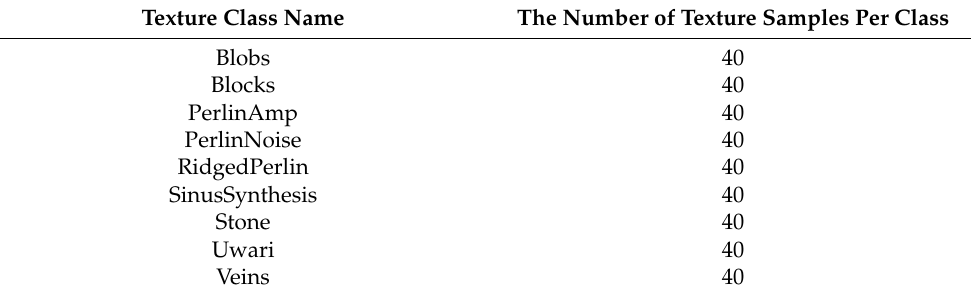
Table 3. Texture classes for the first